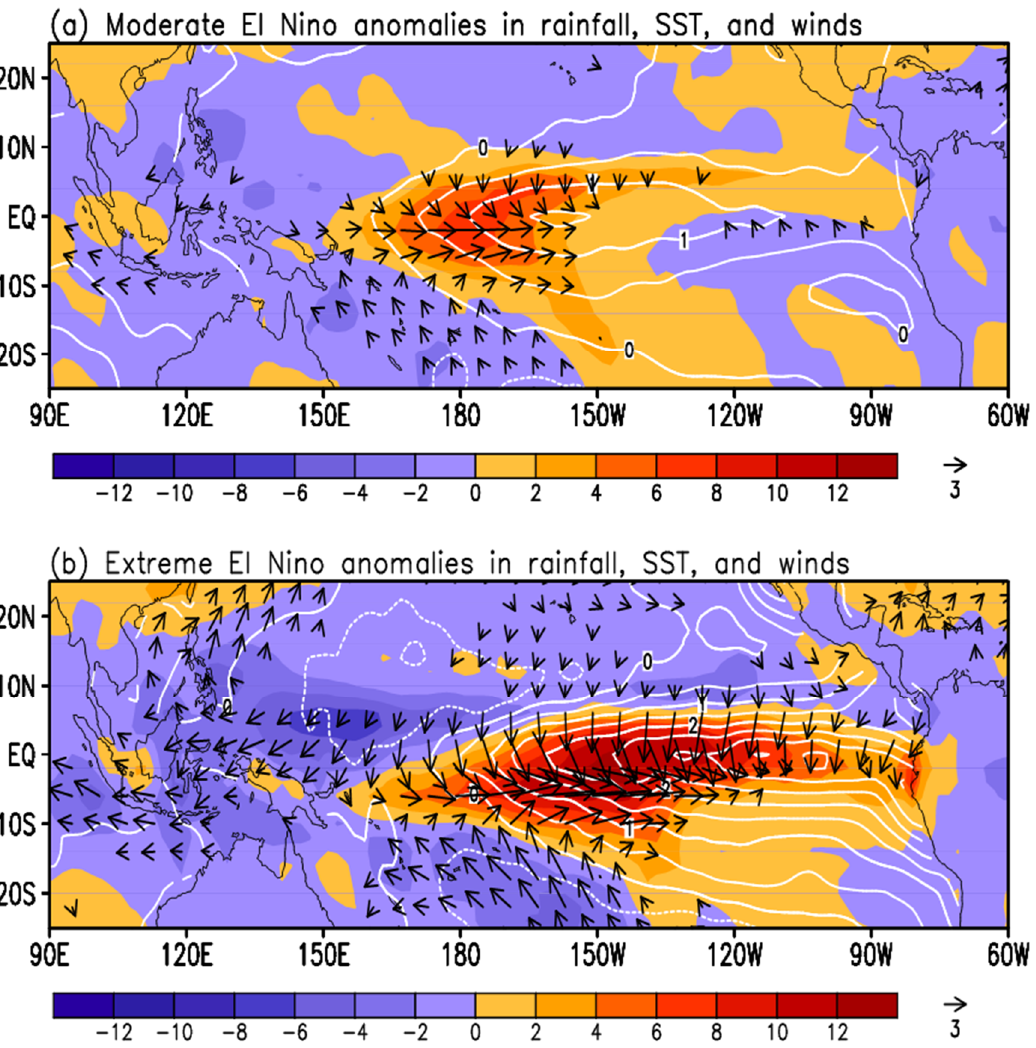
Figure 2. Composite anomalies in 1000 hPa winds (m/s; only wind speeds larger than 1 m/s are shown) and precipitation (color-shaded; mm/day) for ( a ) moderate and ( b ) extreme El Niño events.